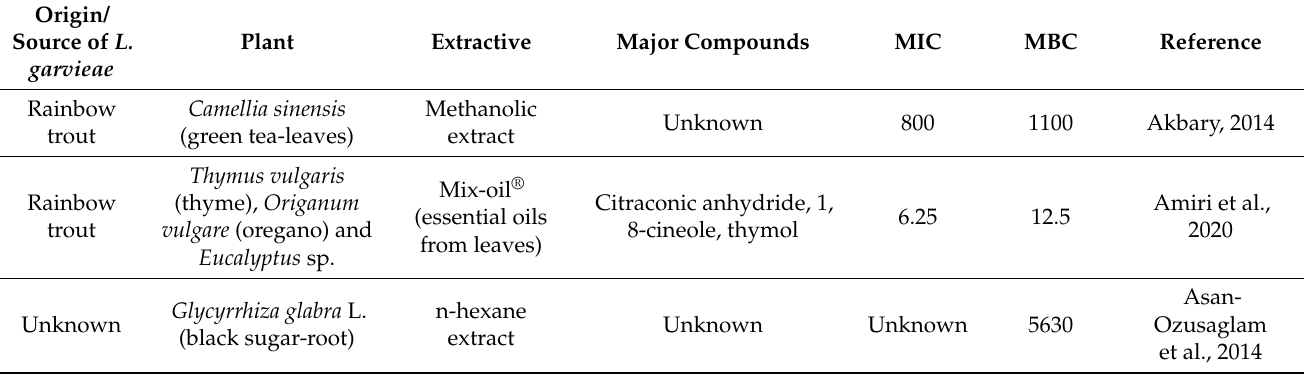
Table 1. Minimum inhibitory concentration (MIC) ( µ g mL − 1 or µ L mL − 1 ) and minimum bactericidal concentration (MBC) ( µ g mL − 1 or µ L mL − 1 ) of plant and lichen extractives against Lactococcus garvieae . The portion of the plant used to prepare the extractives were cited only if stated in the studies. Note: The MIC 50 and MIC 90 of 15 antibiotics against 146 strains of L. garvieae isolated from diseased fish are also given at the end of the